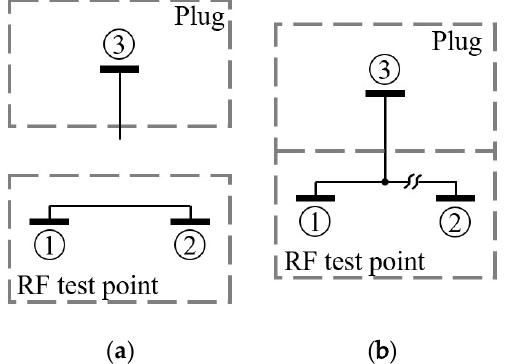
Figure 3. Operating scheme of the RF test point selected for the RF receiver prototype: ( a ) not-mated to plug; ( b ) mated to plug.